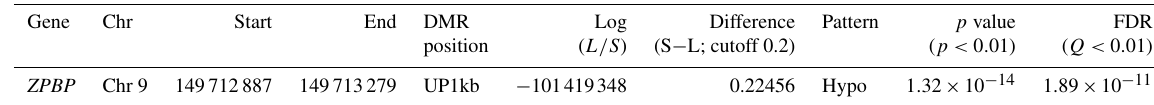
Table 4. Information of DNA methylation of ZPBP .